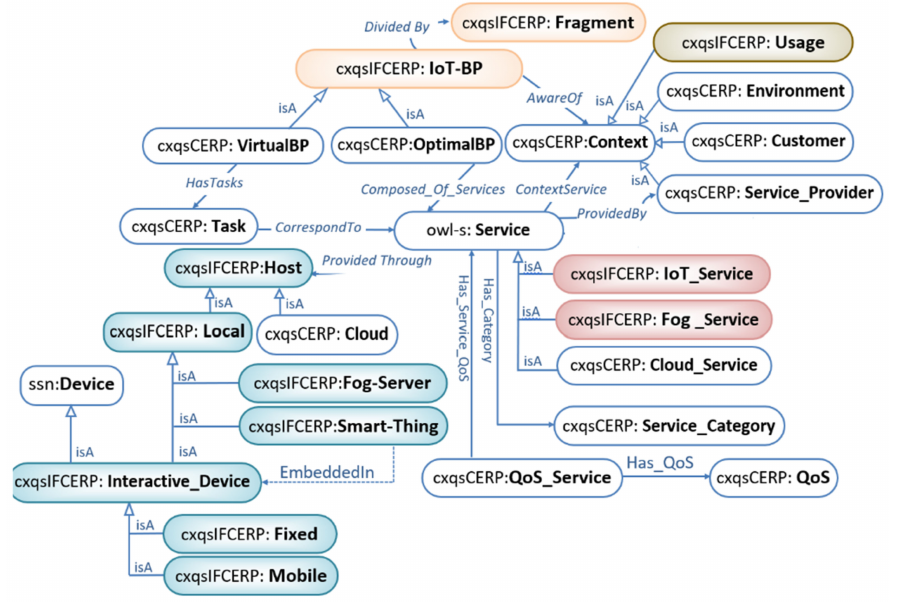
Figure 4. CxQSIoT-Fog-CloudSERP ontology